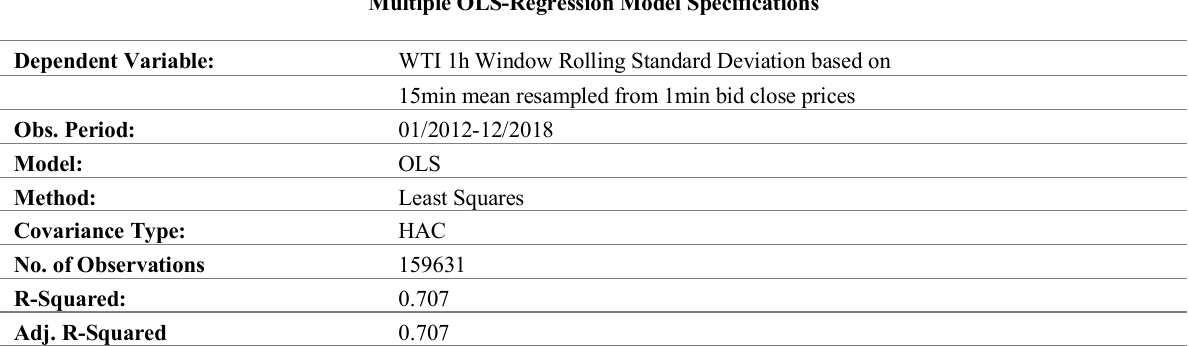
Table 4: Specifications of multiple autoregressive robust OLS-Regression